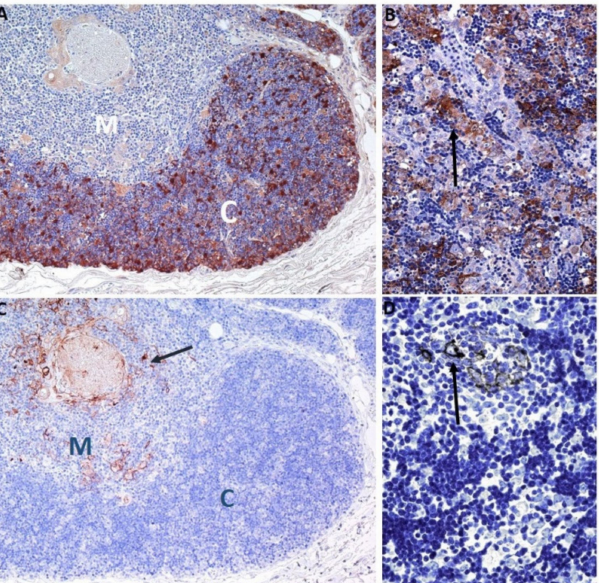
Figure 3. Corticomedullary markers in the thymus and in thymoma. ( A , B ) show thymoproteasome ( β 5t thymoproteasome, β 5t) staining, respectively, in normal thymus by cTEC (a network of reactive TEC is clearly visible) ( A ) and by neoplastic TEC in a Type B2 thymoma ( B ). In ( B ), the dark arrow indicates neoplastic EC with strong β 5t staining; ( C ) claudin 4-R56 stain of normal thymus: all reacting TEC are in the medulla; ( D ) only few EC of the type B2 thymoma are stained with claudin 4-R56, indicated by a dark arrow (courtesy of Prof. Marx and of Prof. Ströbel,